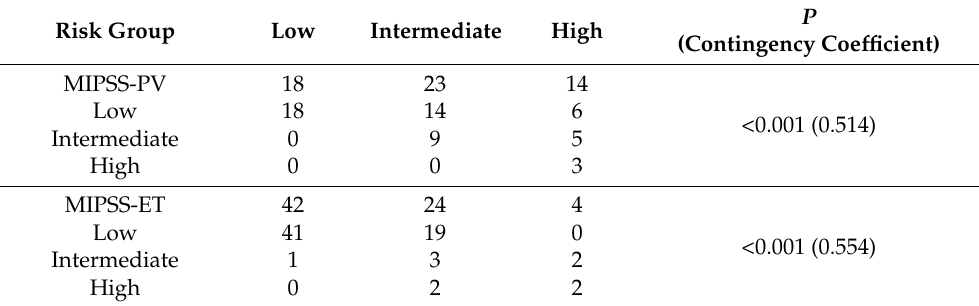
Table 4. Comparison of risk groups in patients with polycythemia vera (PV) and essential thrombo- cythemia